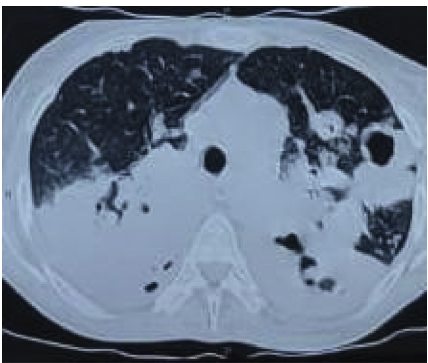
Figure 1: Axial section of CT thorax showing bilateral consoli- dation with necrosis and cavitation.